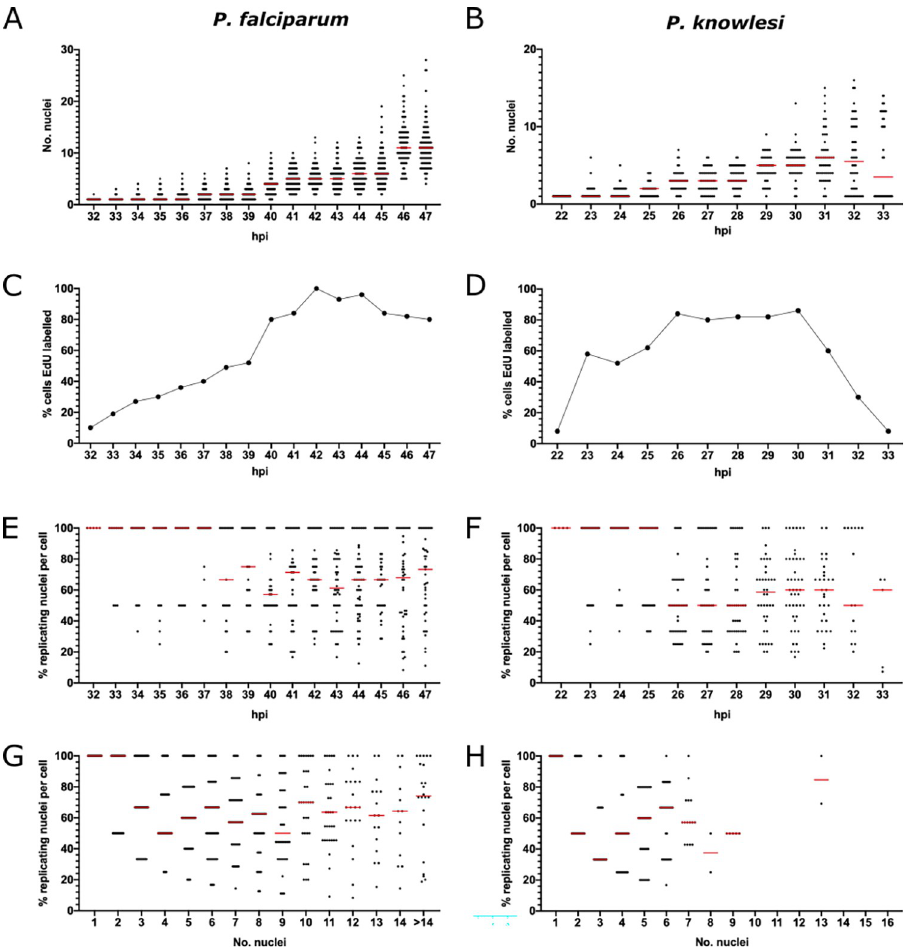
Fig 2. Length and dynamics of S-phase in P . falciparum and P . knowlesi . A, B: Scatter graphs of nuclear numbers at each hour in P . falciparum (A) or P . knowlesi (B), n = 100 cells, medians are shown in red. Biological replicate experiments are shown in S3 Fig. C, D: Percentage of 100 cells showing some EdU labelling at each hour in P . falciparum (C) and P . knowlesi (D). E, F: Percentage of replicating nuclear masses per cell at each timepoint in P . falciparum (E) and P . knowlesi (F), n = 100, medians are shown in red. G, H: Percentage of replicating nuclear masses per cell, re-plotted by number of such masses, in P . falciparum (G) and P . knowlesi (H), n = 100, medians are shown in